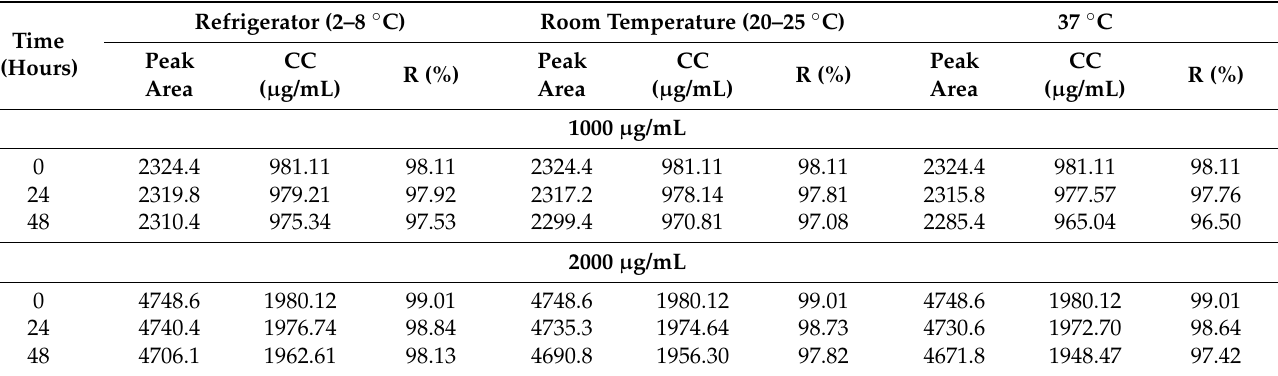
Table 9. Experimental results obtained in the study of the stability over time of M-HCl solutions with concentrations of 1000 and 2000 µ g/mL.